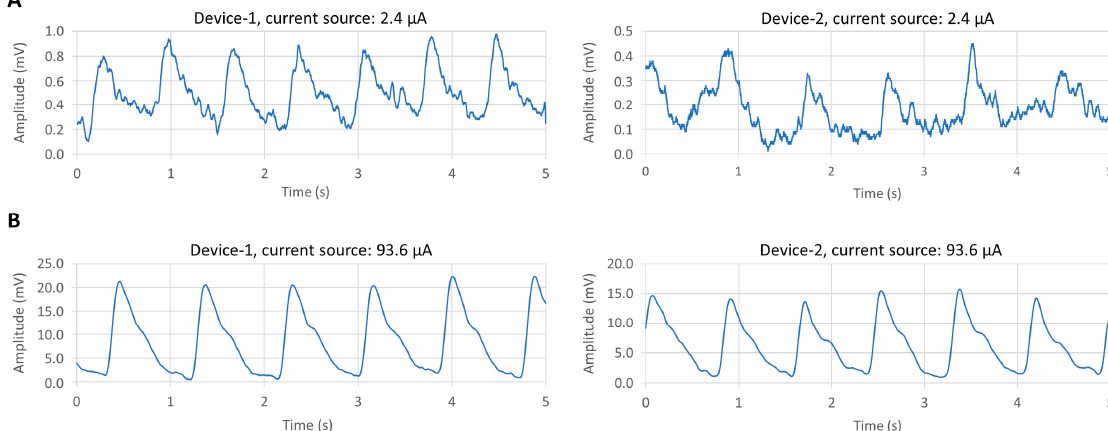
Figure 9. Comparison between the PPG signals from both devices at two different current sources for OLED ( A ) at 2.4 µA and ( B ) at 93.6 µA. Table 2. Summary of the PPG signal quality for Device-1 and Device-2. Device Device No.